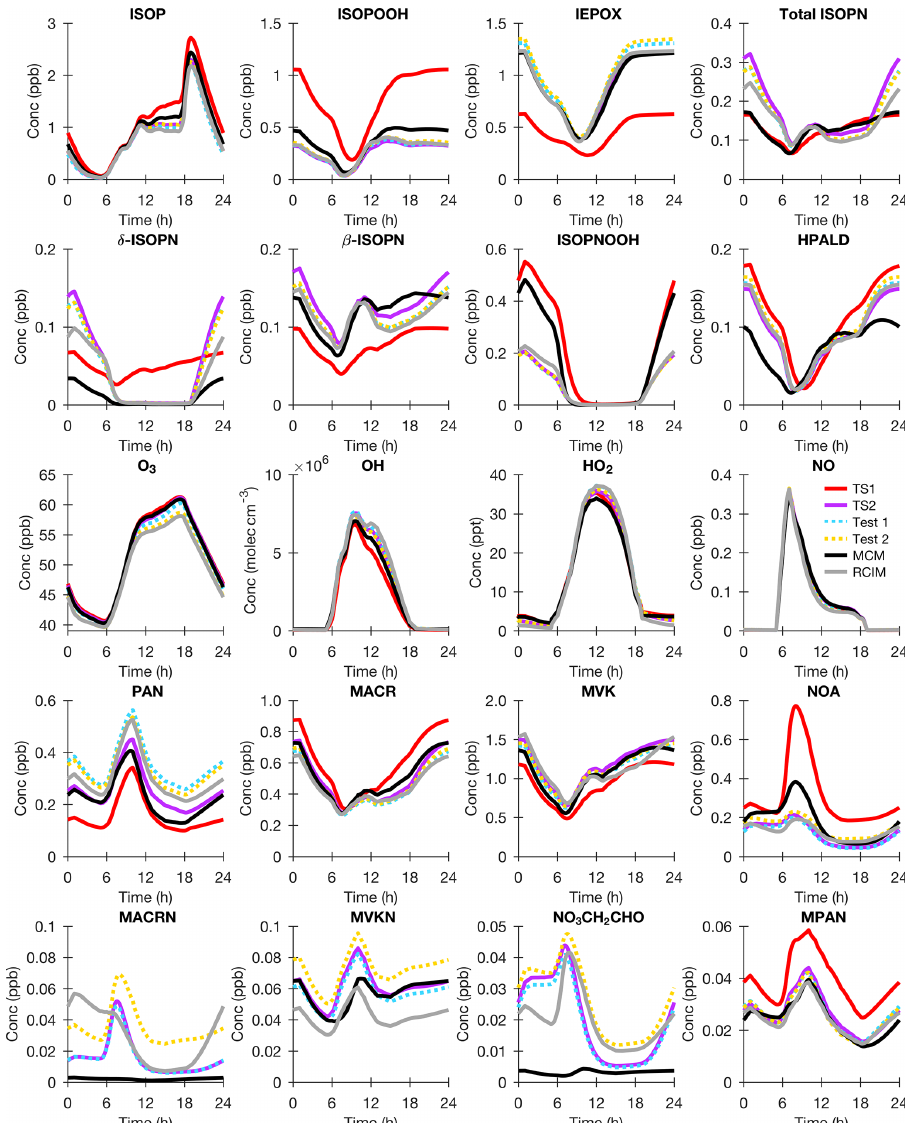
Figure 3. BOXMOX results for isoprene oxidation using TS1 (red), MCM (black), RCIM (gray), TS2 (purple), TS2 with RCIM assumptions for peroxy acetyl nitrate (PAN) and C 4 dihydroperoxy carbonyls (blue; Test 1), and TS2 with RCIM assumptions for PAN, C 4 dihydroperoxy carbonyls, and carbonyl nitrates (gold; Test 2). The model configuration is explained in Sect. 3.1. The following acronyms are used: ISOP (isoprene), ISOPOOH (isoprene hydroxy hydroperoxide), IEPOX (isoprene dihydroxy epoxide), ISOPN (isoprene hydroxy nitrate), ISOP- NOOH (isoprene nitrooxy hydroperoxide), HPALD (isoprene hydroperoxy aldehyde), O 3 (ozone), OH (hydroxyl radical), HO 2 (hydroperoxy radical), NO (nitrogen monoxide), PAN (peroxy acetyl nitrate), MACR (methacrolein), MVK (methyl vinyl ketone), NOA (propanone ni- trate), MACRN (methacrolein hydroxy nitrate), MVKN (methyl vinyl ketone hydroxy nitrate), NO 3 CH 2 CHO (ethanal nitrate), and MPAN (methacryloyl